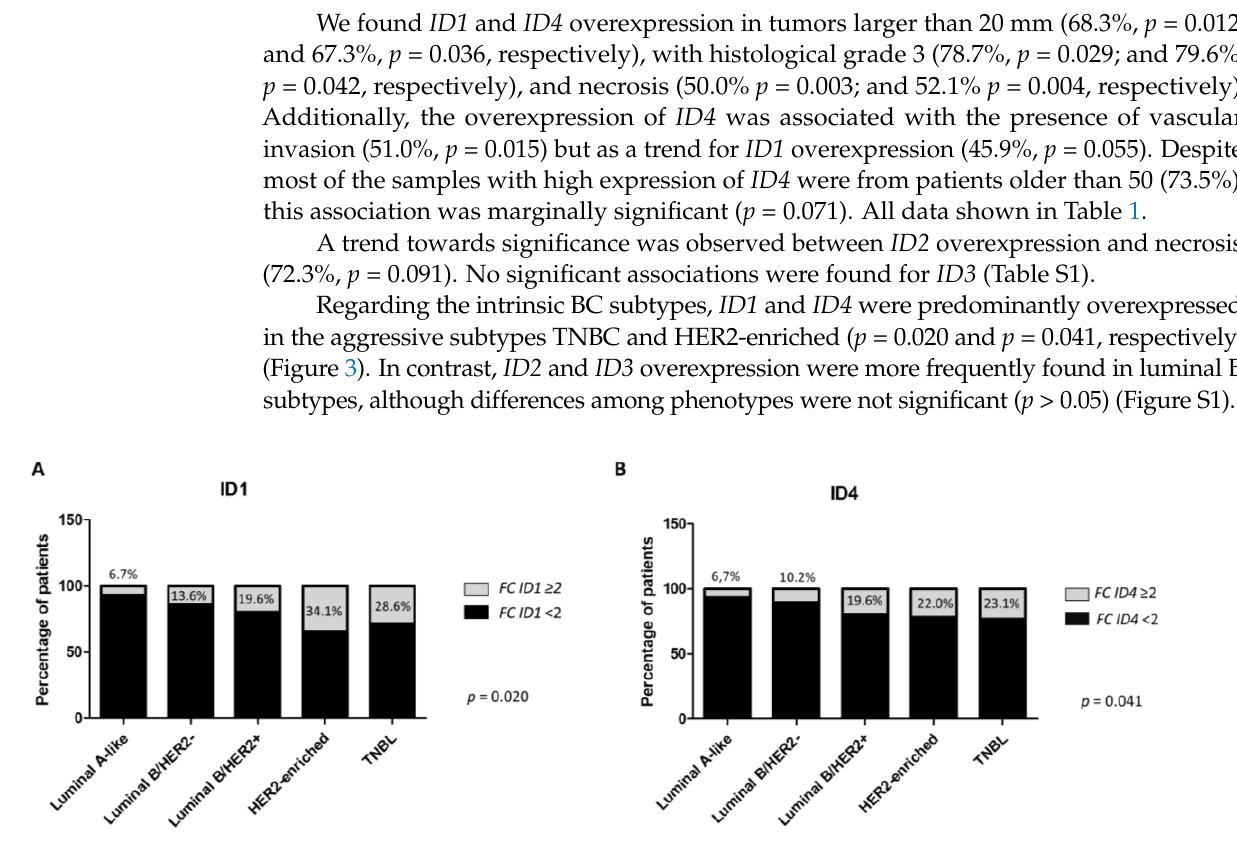
Figure 3. Percentage of samples overexpressing ID1 ( A ) and ID4 ( B ) at mRNA level in each breast cancer immunophenotype. TNBL, triple-negative basal-like.